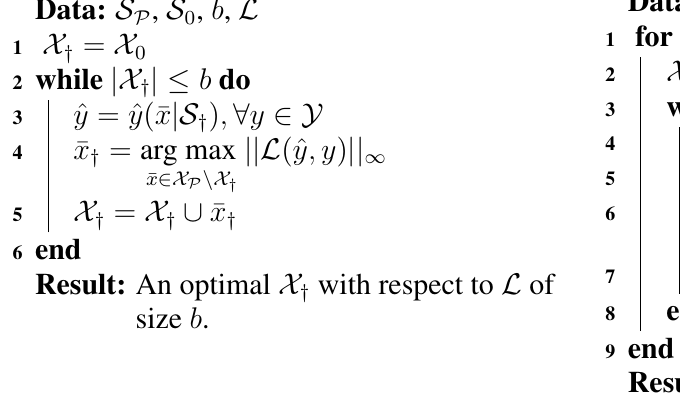
Algorithm 2: Independent support optimiza- tion for every σ . Figure 1: Pseudo code for Pool Active Learning. The support S includes the sample X on which it is